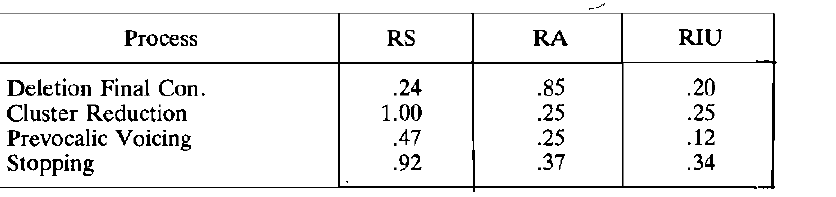
TABLE II: Spontaneous Speech Analysis: